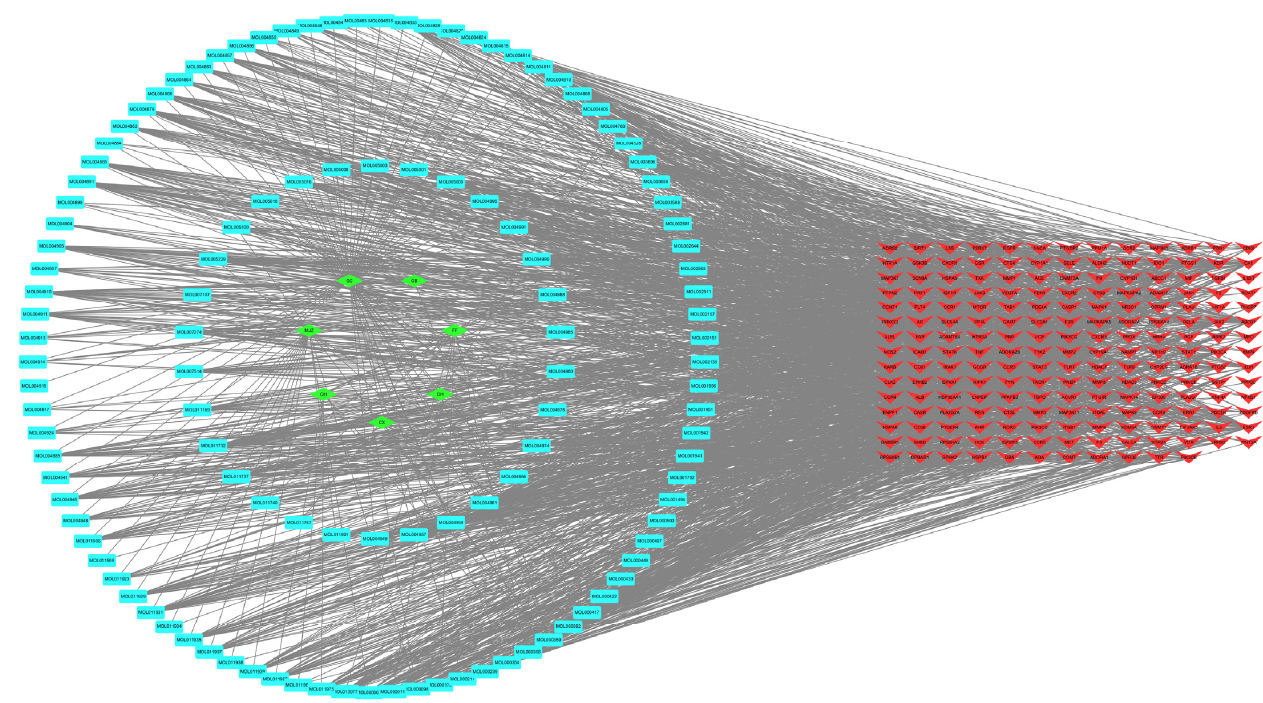
Figure 3. Component–target interaction network (green diamond: QHSSD drugs; blue rectangle: QHSSD chemical compositions; red arrow: common potential targets of QHSSD and